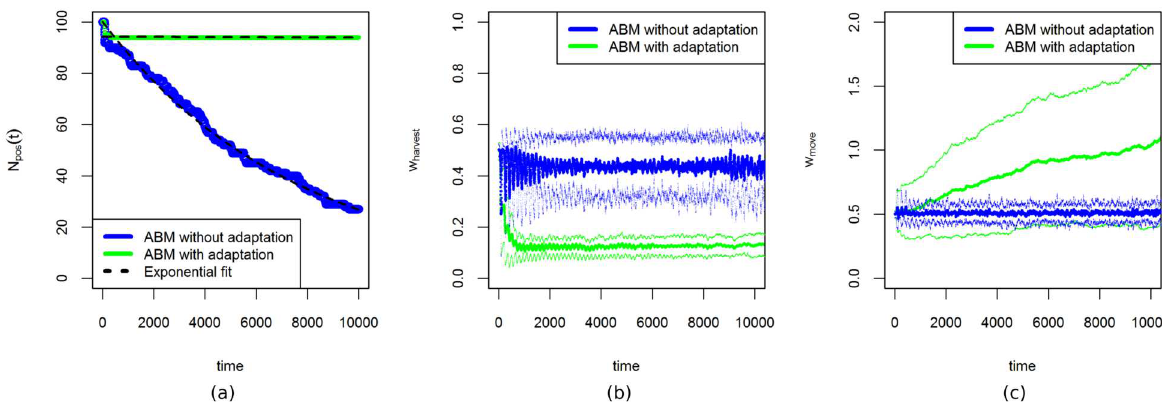
Fig 10. Effect of adaptation on resilience. (a): Plot of the percentageof model runs with a positive population N pos ( t ) as a function of time. We used 100 replicateruns at E h = 0.07, for both versions of the ABM. The dashedlines correspond to exponential fits (Eq 9). Without adaptation, an increasingnumberof runs go to extinction,whereas with adaptation there is extinctiononly on short time-scales. (b): Mean value of w harvest over the agents of all the 100 replicate runs of the ABMs with adaptationand without adaptation. The upper and lower lines show the mean plus or minus one standarddeviation.(c): The mean value of w move over the agents of all the 100 replicate runs of the ABMs with and without adaptation.The upper and lower lines show the mean plus or minus one